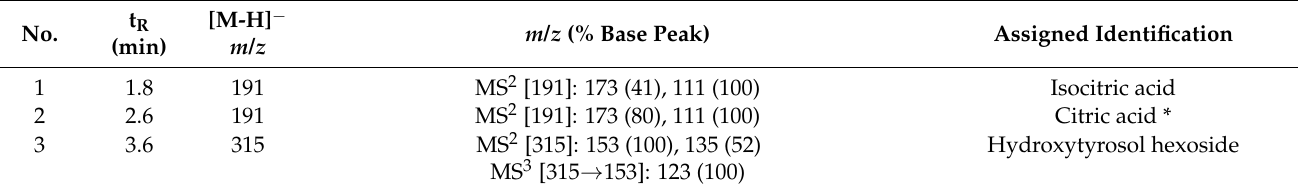
Table 1. Characterization of phytochemicals found in extracts raw and steamed of Portulaca oleracea by HPLC–DAD/ESI–MS n .